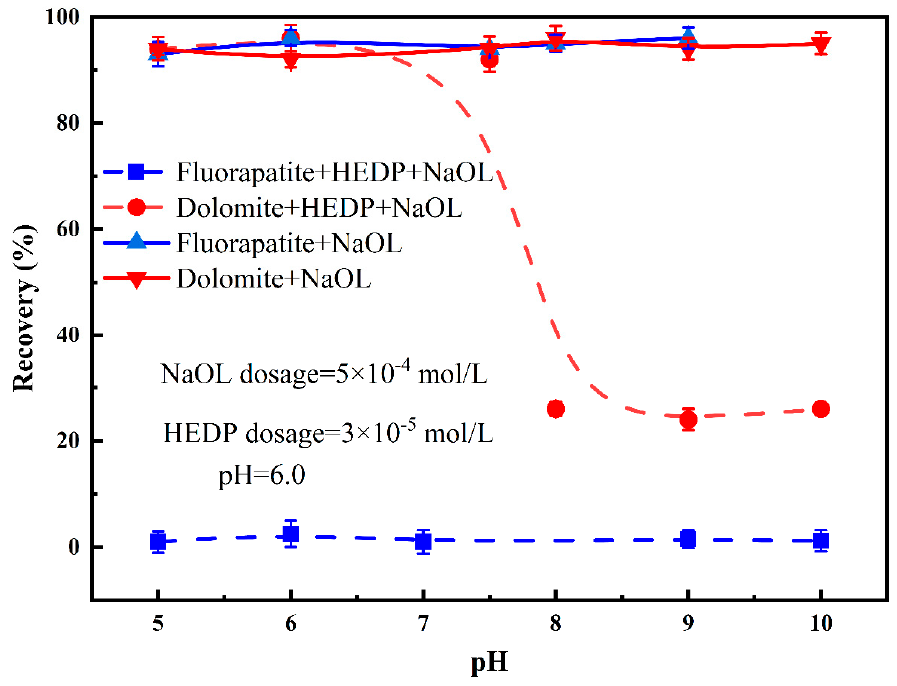
Figure 5. Influence of pH on flotation behavior of fluorapatite and dolomite with and without the addition of HEDP in the presence of NaOL.